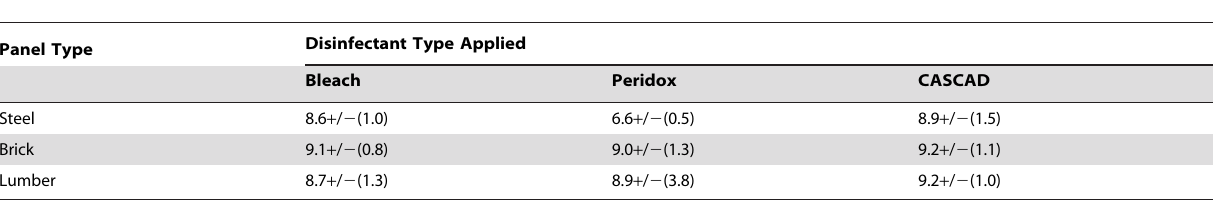
Table 5. Cumulative log10 reduction after reapplication of decontamination solution (SD*).